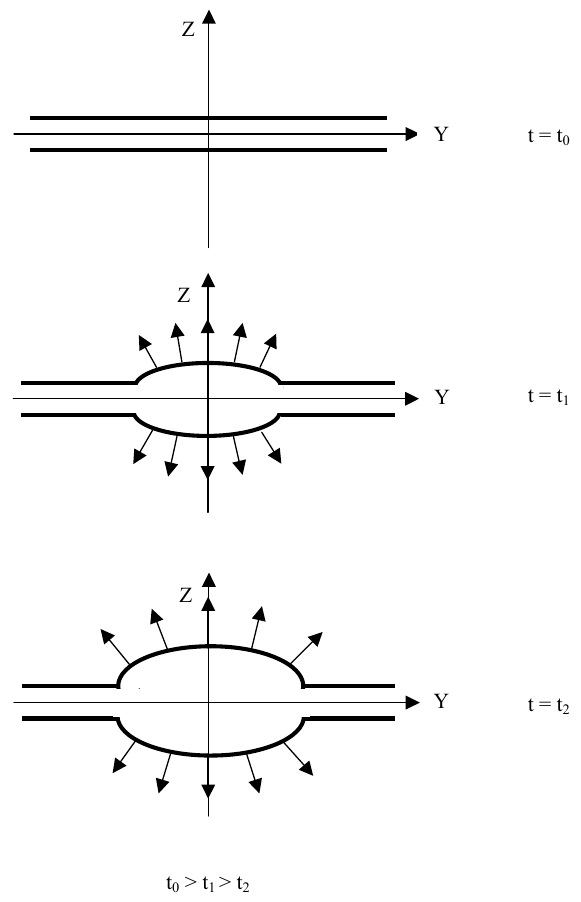
Fig. 21. An illustration of a model expansion of the plasma sheet in the GSM–YZ plane as viewed from the Earth looking tailward. The onset region for the expansion is in the central GSM–Y